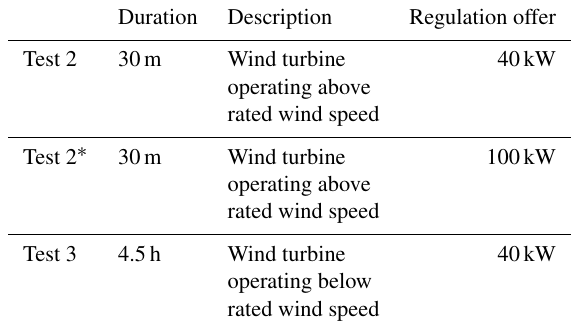
Table 1. Summary of the tests presented in this work. The asterisk in Test 2 ∗ is chosen to separate it from results in Test 2 and to be consistent with other project literature. Functionally, both tests are